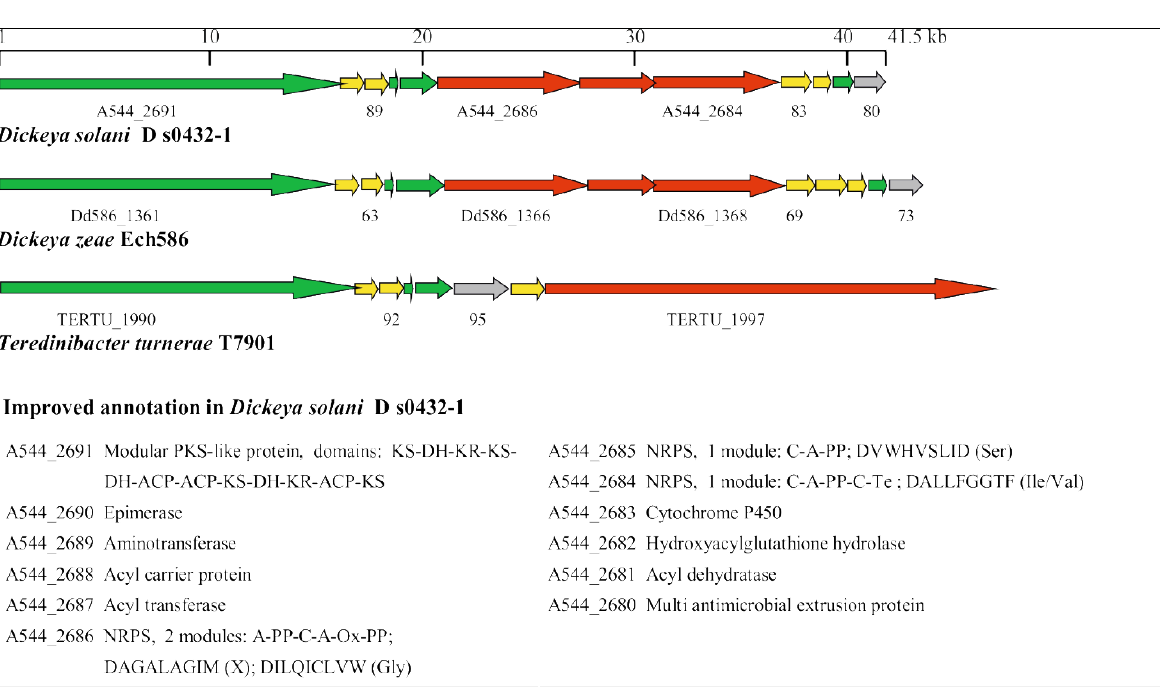
Figure 3. Alignment of the PKS/NRPS cluster at genomic coordinates of 3092397–3133943 in D. solani D s0432-1 with the two closest homologs in D. zeae Ech586 and T. turnerae T7901. The improved annotations of the genes, domains, substrate specificity conferring amino acids of the adenylation domains of NRPSs and predicted amino acids in the synthetized molecules are mentioned in the table within the figure. The colors of open reading frames (ORFs) indicate their functions: red for NRPS, green for PKS, grey for transport and yellow for tailoring. For PKS, the following domain abbreviations are used: acyl carrier protein (ACP), ketoacyl synthase (KS), ketoreductase (KR) and dehydratase (DH). For NRPS, the domains are: adenylation (A),